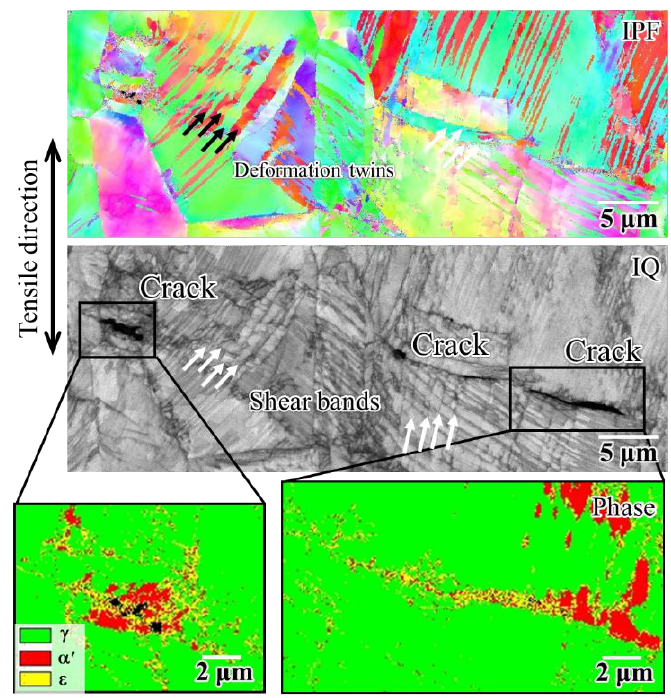
Figure 11. EBSD maps (IQ, IPF and phase maps) of surface of ( a ) uncharged specimen before tensile test and specimens subjected to tensile straining to 0.2 and unloading at −196 °C; ( b ) uncharged specimen, ( c ) conventionally charged specimen and ( d ) specimen charged by modified method.